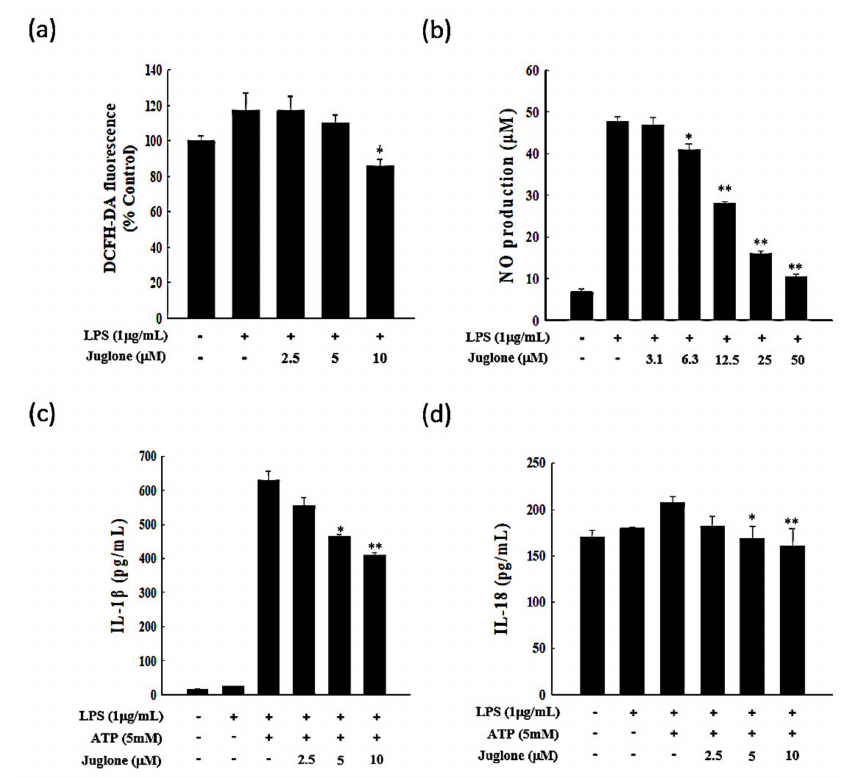
Figure 2. E ff ects of juglone on the production of inflammatory mediators. ( a ) reactive oxygen species (ROS) production in J774.1 cells treated with lipopolysaccharide (LPS). Cells were treated with di ff erent concentrations of juglone (2.5, 5, and 10 µ M) for 2 h, followed by treatment with 1 µ g / mL LPS for an additional 24 h. ( b ) NO production in J774.1 cells treated with LPS. Cells were treated with increasing concentrations of juglone (3.1–50 µ M or 0 µ M control) for 2 h, followed by treatment with 1 µ g / mL LPS for an additional 24 h. The levels of NO in the cell culture media were measured using Griess reagent. ( c , d ) E ff ects of juglone on the LPS / ATP-induced secretion of interleukin-1 β (IL-1 β ) and IL-18 in J774.1 cells. J774.1 macrophages were treated with di ff erent concentrations of juglone for 2 h, followed by treatment with 1 µ g / mL LPS for 6 h and treatment with 5 mM ATP for 1 h. The levels of IL-1 β and IL-18 secreted in the culture medium were analyzed by enzyme-linked immunosorbent assay (ELISA). Data are presented as mean ± SD of three independent experiments. * p < 0.05; ** p < 0.01 vs. LPS or LPS + ATP cells,